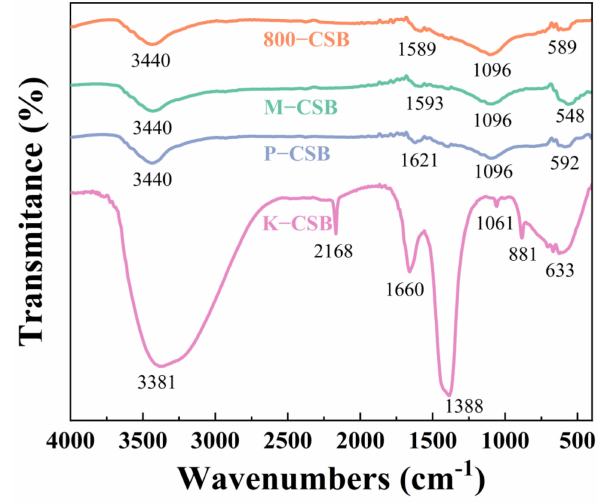
Figure 4. Infrared spectrum of crab shell